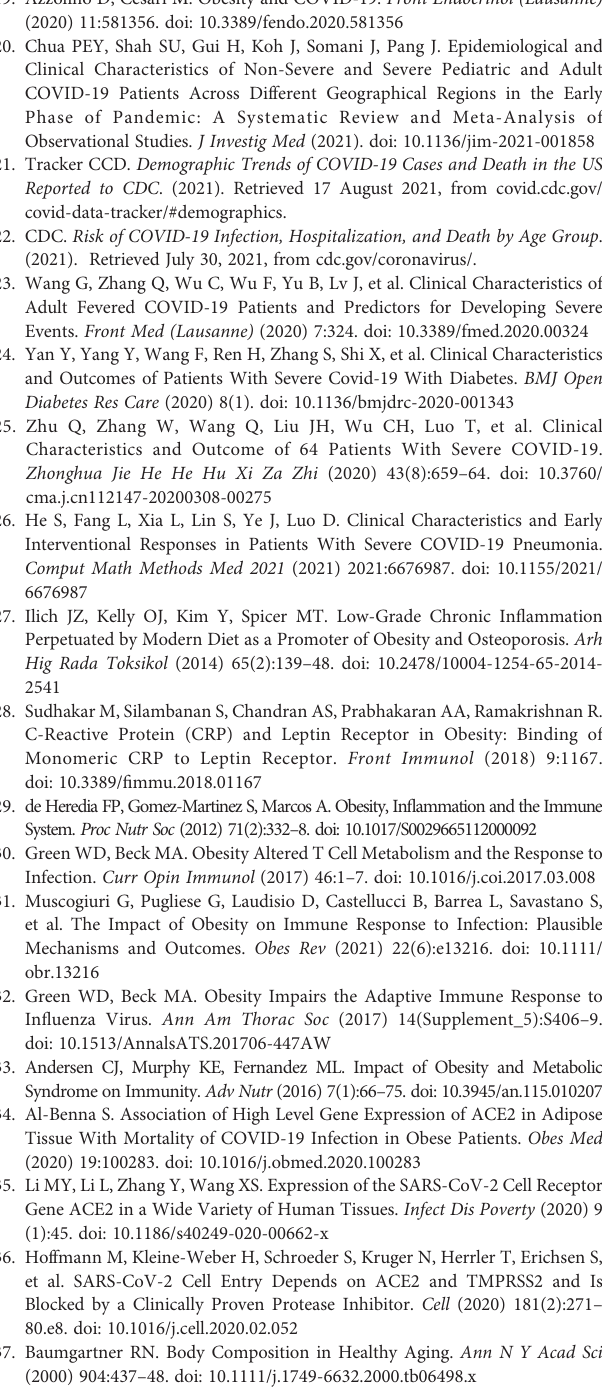
Supplementary Table 7 | Correlation and Simple linear regression values of humoral immunity against SARS-CoV-2. Supplementary Table 8 | Correlation and Simple linear regression values of the frequency of CD4+ and CD8+ T cells secreting various cytokines in response to anti-CD3/CD28 stimulation in young and aged